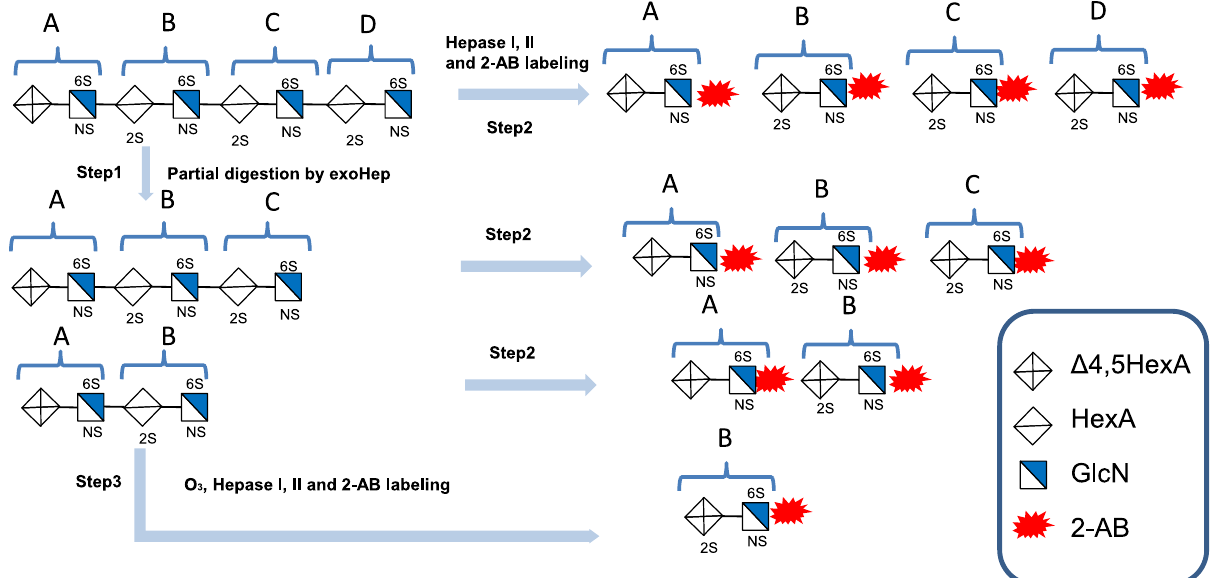
Fig. 6 Strategy for the exo-sequencing of unsaturated HP octasaccharides. The strategy is divided into three steps: fi rst, the octasaccharide was partially digested by BIexoHep for isolating and preparing its nonreducing end hexasaccharide (UDP6 NE ) and tetrasaccharide (UDP4 NE ) fractions. Then, the disaccharide compositions of UDP8 NE , UDP6 NE and UDP4 NE were analyzed by complete digestion with Hepases I and II followed by 2-AB labeling and anion-exchange HPLC. By comparing the molar ratio change of disaccharides in UDP8 NE and UDP6 NE , the reducing end disaccharide (D) could be deduced, and similarly the disaccharide located at C site could be determined by comparing the disaccharide compositions of UDP6 NE and UDP4 NE too. Finally, to determine the type of disaccharide at B site, the UDP4 NE was treated with O 3 to remove the unsaturated uronic acid at the nonreducing end and further digested with Hepases I and II for disaccharide composition analysis. Combining all the disaccharides ʼ information, the A site could be deduced. preliminary sequence of P8-4 can be deduced as Δ UA1- 4GlcNS6S was detected, indicating that the disaccharide at B site 4GlcNS6S1-4HexUA2S1-4GlcNS6S1-4HexUA2S1-4GlcNS6S1- was HexUA2S1-4GlcNS6S too. Finally, based on the disaccharide 4HexUA2S1-4GlcNS6S (Supplementary Table 6). By using the composition of UDP4 NE-P8-4 , the nonreducing end disaccharide same method, the preliminary sequences of P8-1, P8-2, P8-3, and (A) of P8-4 must be Δ UA1-4GlcNS6S. Taken together, the